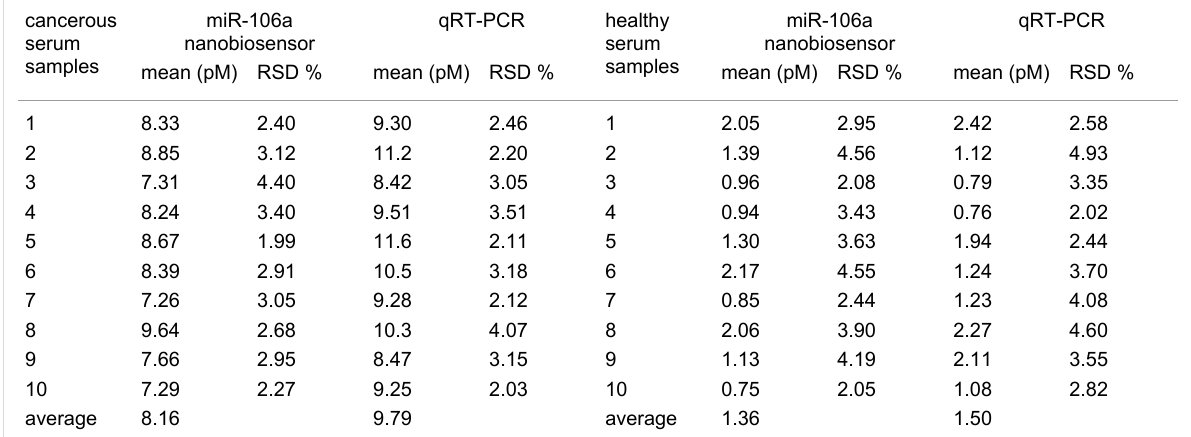
Table 2: Comparison of miR-106a detection in serum samples of GC patients and healthy volunteers using the nanobiosensor and qRT-PCR. Data are presented as the means of five replicates. cancerous serum samples